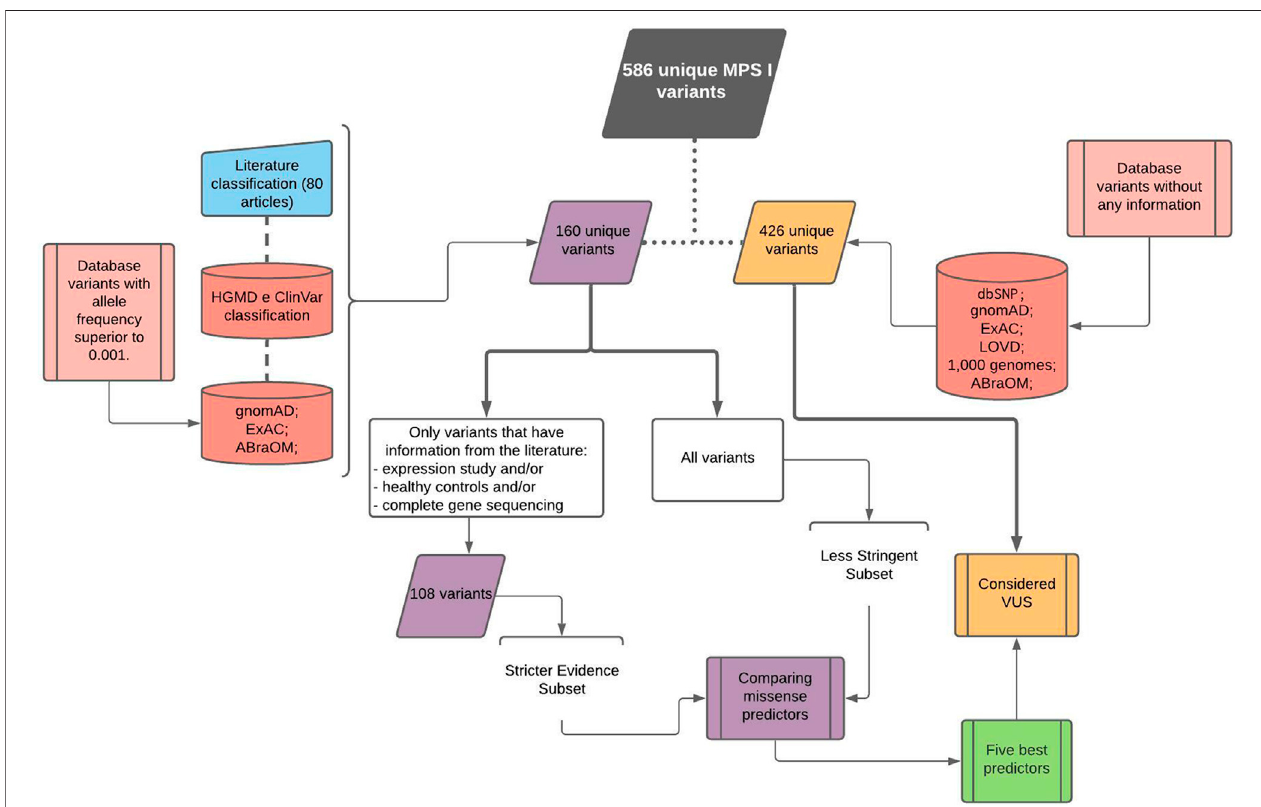
FIGURE 1 | Work fl ow chart showing variant retrieval and